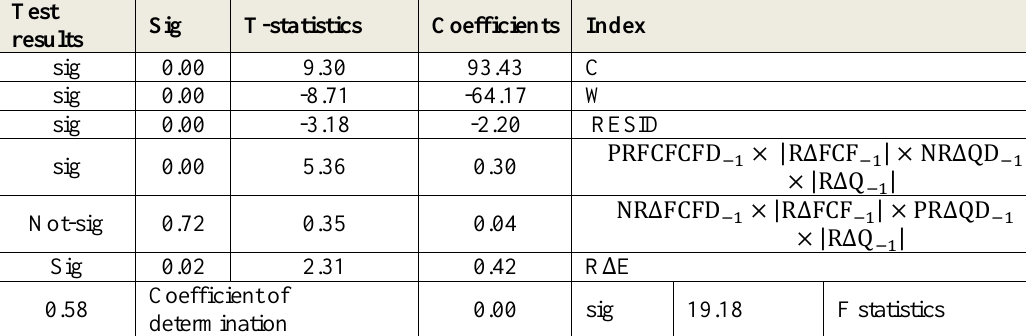
Table 1. Hausman Endogeneity